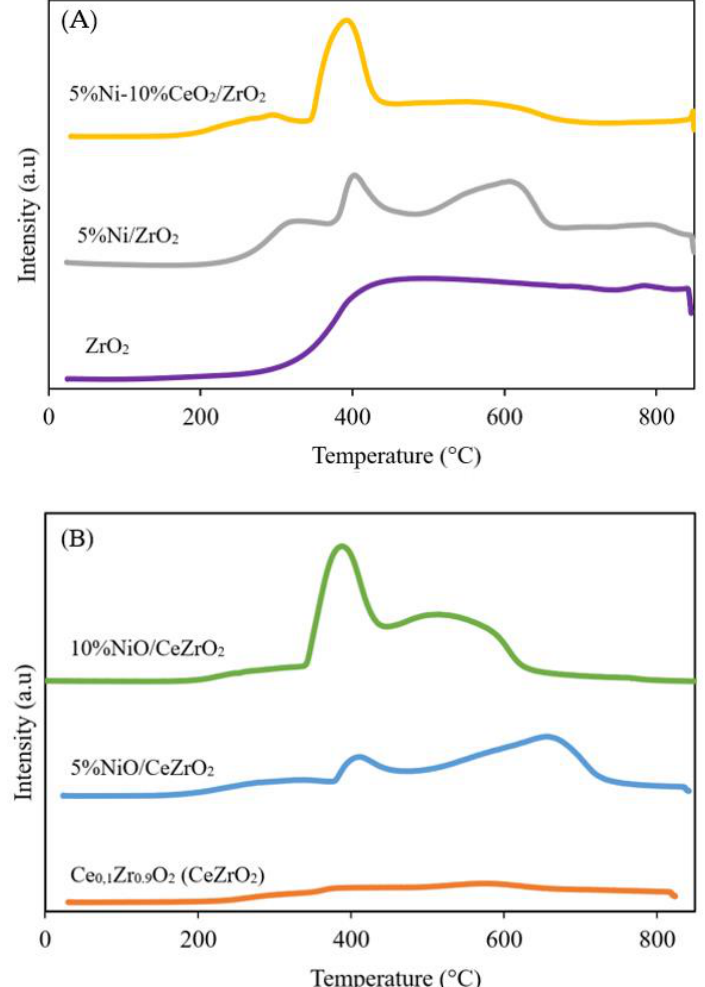
Figure 4. H 2 -TPR profiles of catalyst: ( A ) ZrO 2 -supported Ni catalyst and ( B ) CeZrO 2 -supported Ni catalyst.